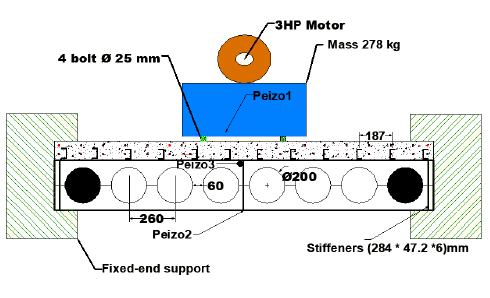
Figure 2: The application system of the harmonic load